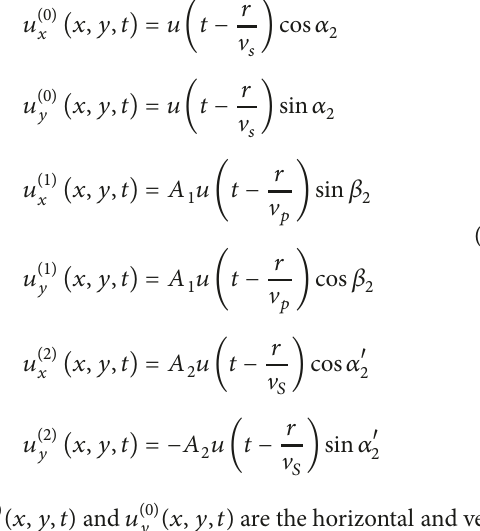
where 𝑢 (0) 𝑥 (𝑥, 𝑦, 𝑡) and 𝑢 (0) 𝑦 (𝑥, 𝑦, 𝑡) are the horizontal and vertical incident wave fields of incident P wave, respectively; (𝑥, 𝑦, 𝑡) and 𝑢 (1) (𝑥, 𝑦, 𝑡) are the horizontal and vertical 𝑢 (1) 𝑥 𝑦 wave fields of reflected P wave, respectively; 𝑢 𝑢 (2) (𝑥, 𝑦, 𝑡) are the horizontal and vertical wave fields of 𝑦 reflected SV wave,